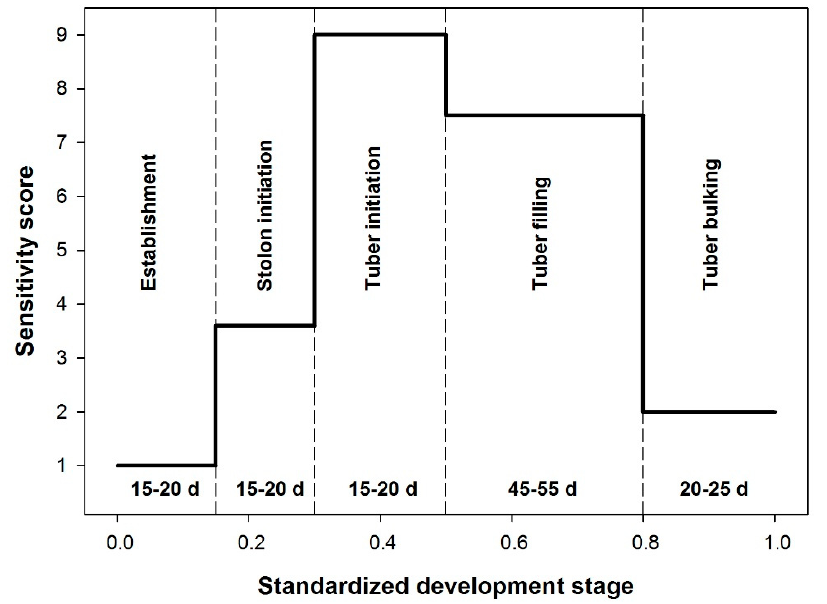
Figure 2. Literature based sensitivity score for standardized development stages (0 = planting; 1 = physiological maturity) of potato. Development stages and durations adapted from Doorenbos and Kassamm (1979) [29] and Obidiegwu et al. (2015) [5].